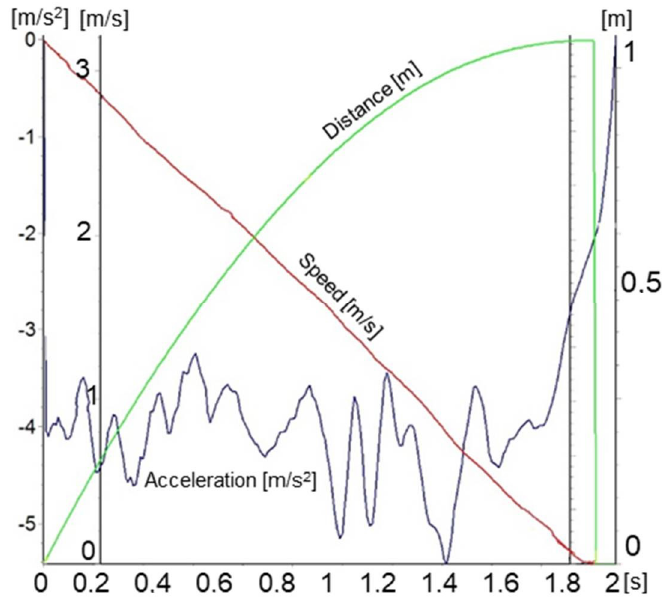
Figure 17. The dynamic characteristics of the 6 × 6 robot when braking on the slope, determined with the help of an inertial sensor system.